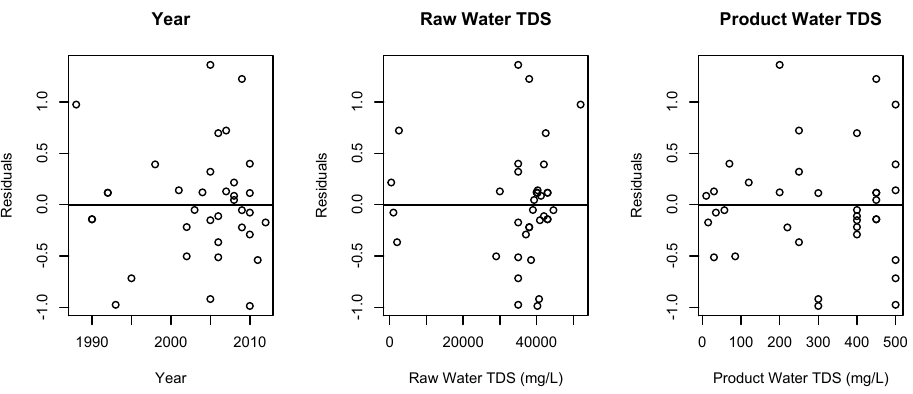
Figure A2. Residual plots for the municipal-scale multiple linear regression model show minor heteroscedasticity and negligible trending indicating autocorrelation.